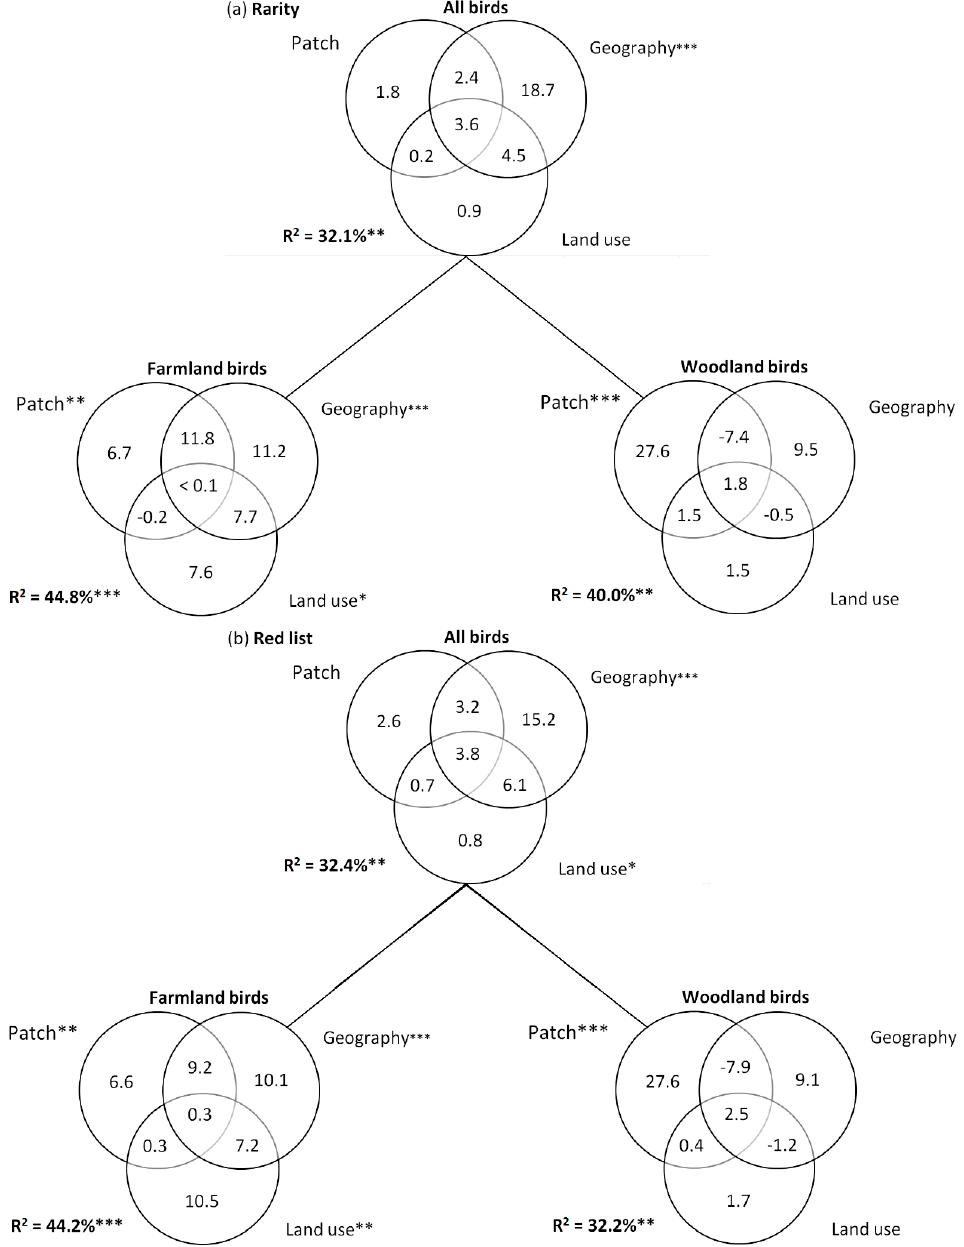
Figure 1. Results of the partial regression analyses for ( a ) rarity and ( b ) the red-list index of all birds, farmland specialists, and woodland specialists for the studied predictor categories representing patch, topography, and land use in traditional fruit orchards. Significance levels are * p < 0.05, ** p < 0.01, and *** p < 0.001. Only the net effects (independent R 2 ) of predictor levels can be tested statistically, while the overlapping sections (shared R 2 ) cannot be tested. Negative fractions are given by the correlation structure of the predictors, within which direct and indirect positive and negative effects of the individual predictors are combined [27].